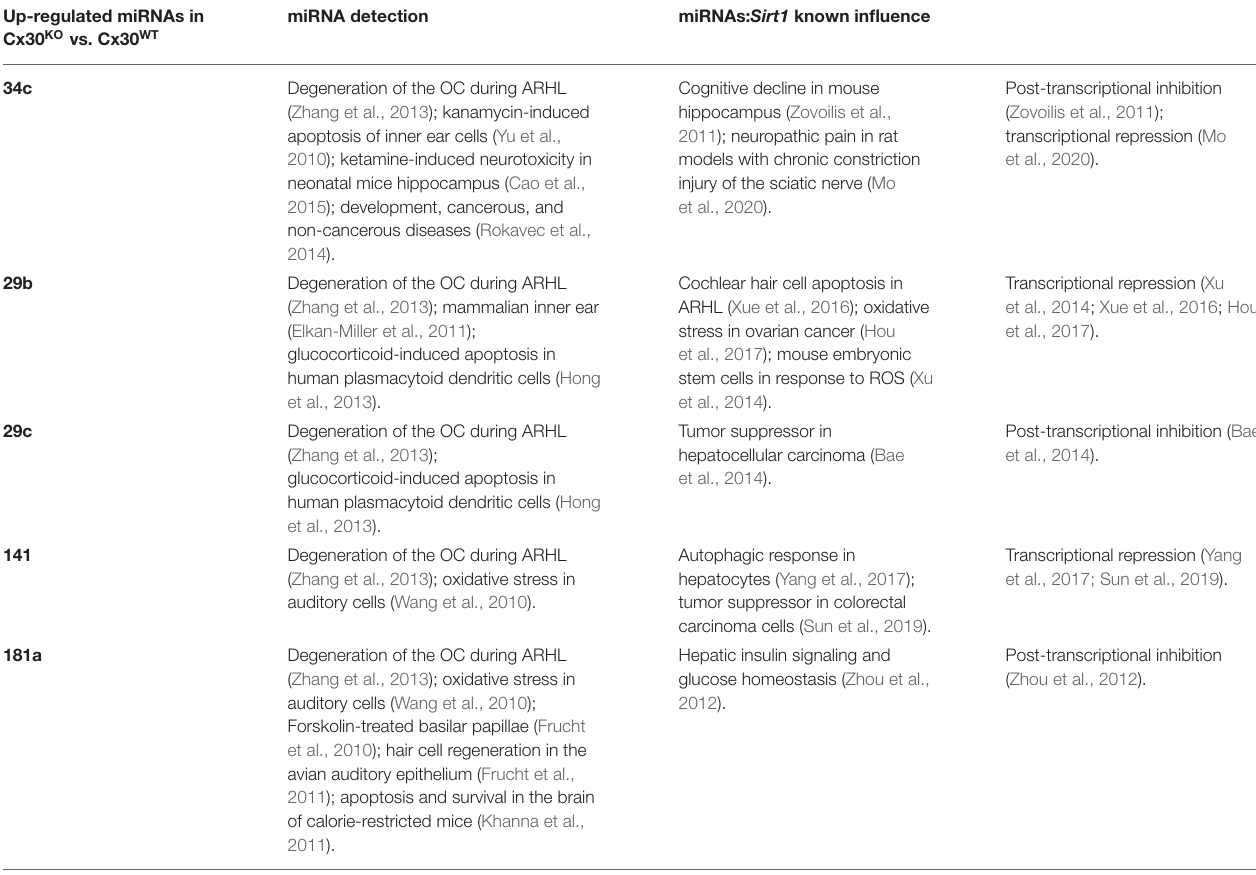
TABLE 1 | Deregulated